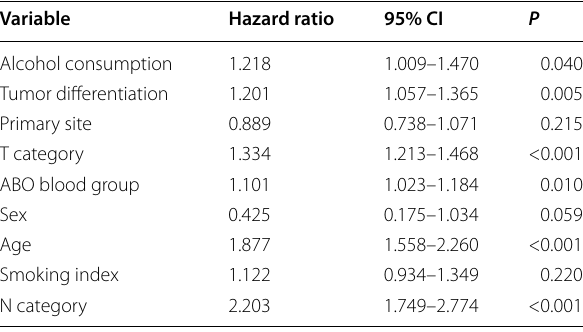
Table 3 Multivariate analysis of OS with the Cox propor- tional hazards